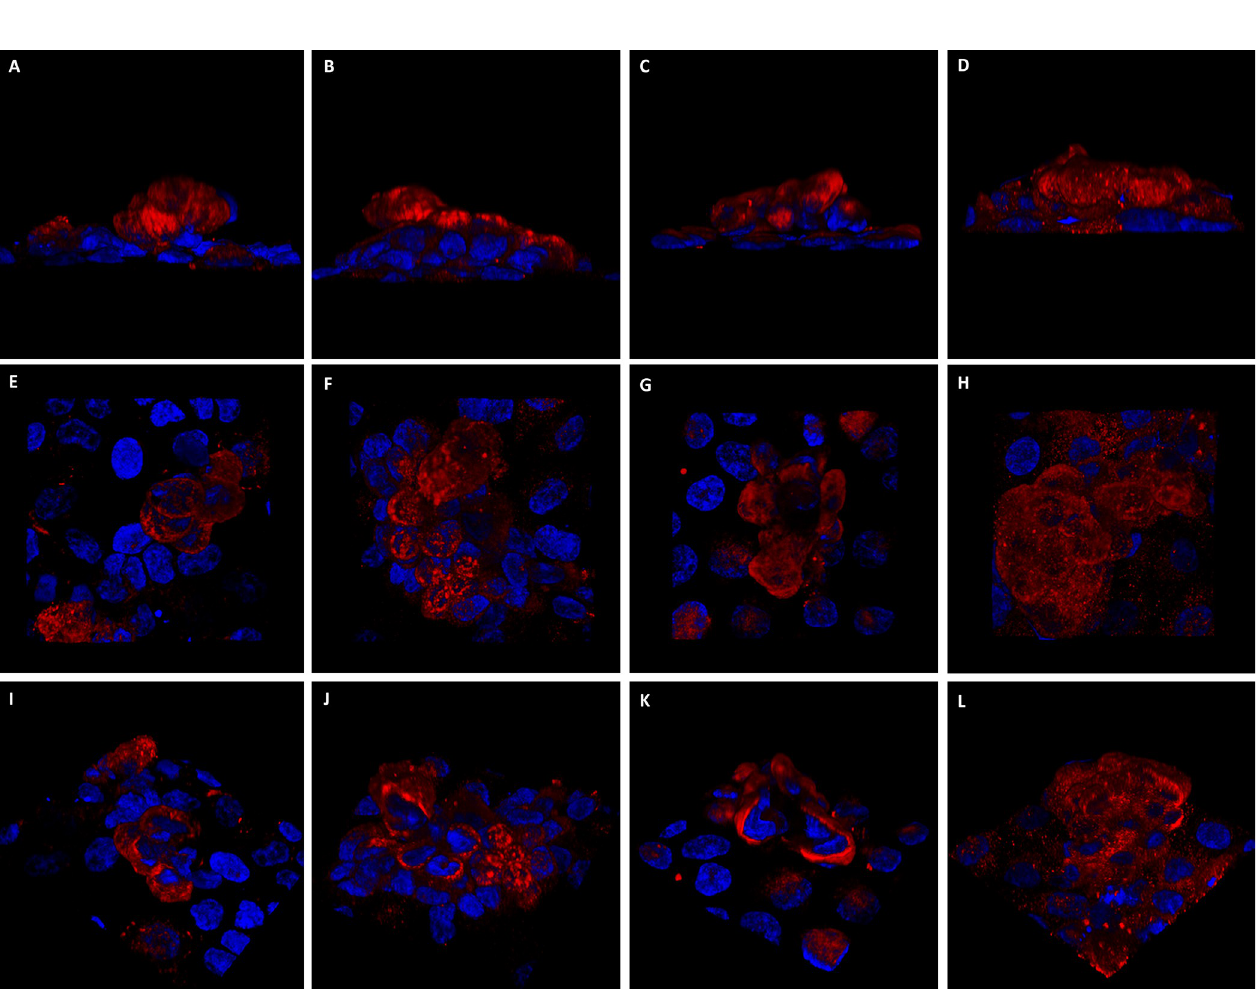
Fig 7. Three dimensional projection of the intracellular localization for the MT-3 binding partners. Each of the binding partners are shown in red: Myosin-9 (A, E and I); tropomyosin 3 (B, F and J); enolase 1 (C, G and K); and aldolase A (D, H and L) and nuclei are shown in blue. The 3 different 3D views shown are side angle view (A-D), apical surface from the top down (E-H), and a portion of the field cut away in a 3D slice (cut in the X, Y, and Z planes) are shown in (I-K). All panels shown are for a representative dome structure.